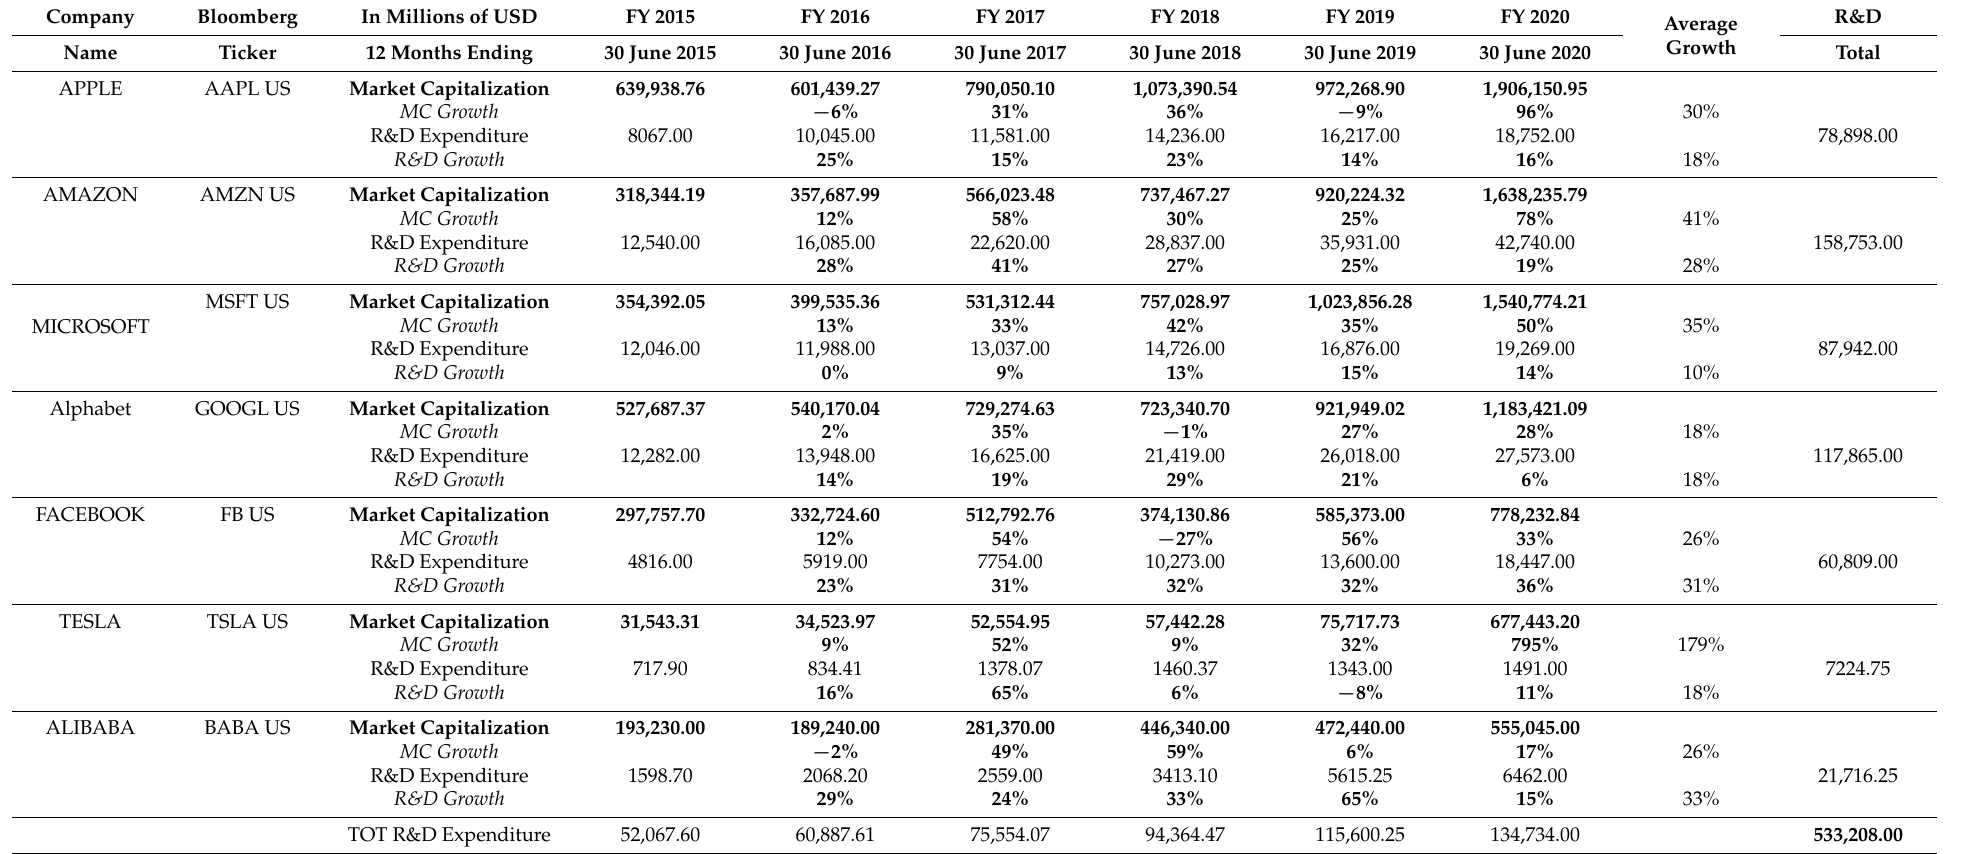
Table 1. Biggest companies’ capitalisation, R&D expenditures, and growth. Source: